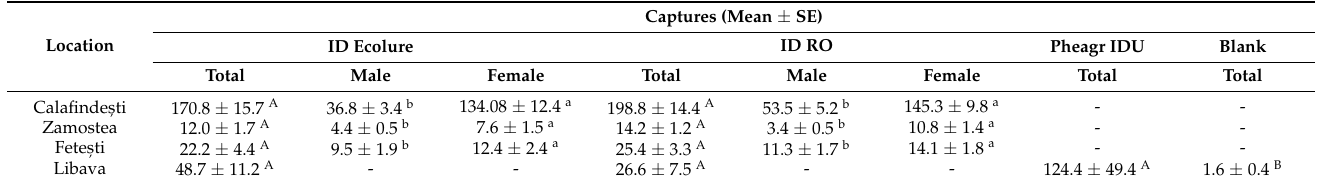
Table 9. Comparison of Ips typographus captures obtained at traps baited with different dispenser